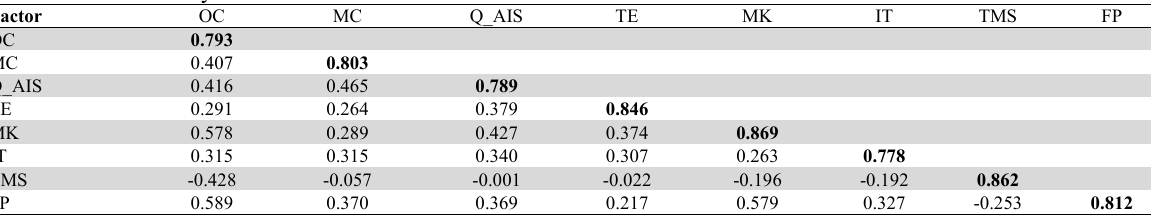
Differential value analysis